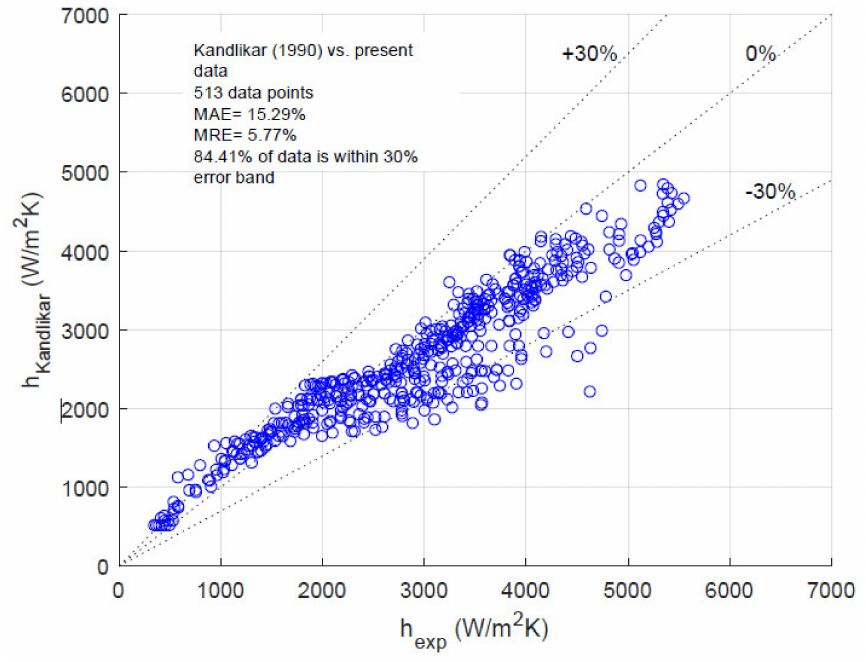
Figure 11. Kandlikar correlation